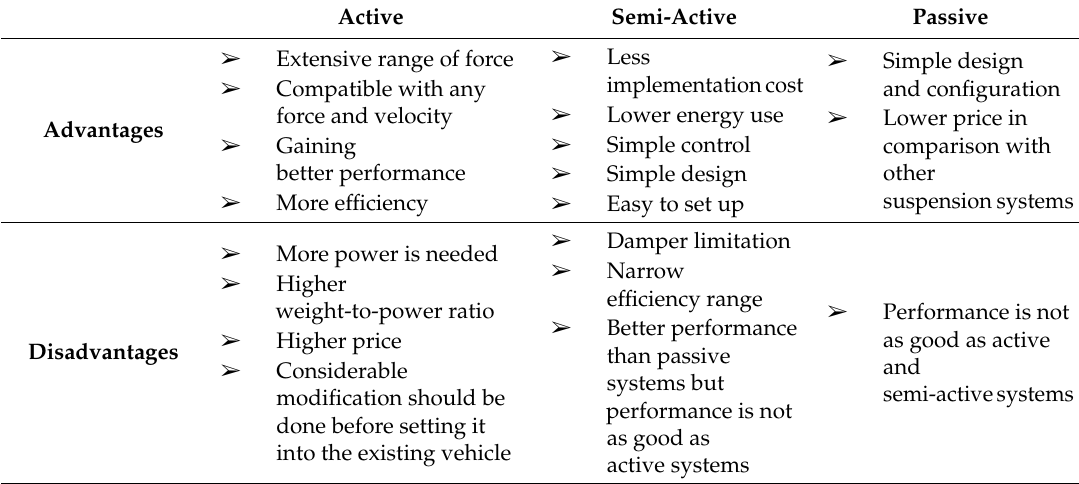
Table 1. Comparison of the three seat suspension